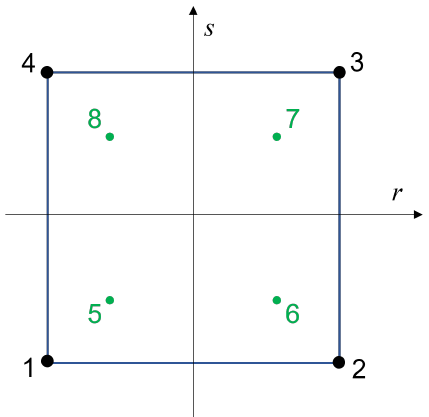
Figure 2. Four-noded quadrilateral element in the local curvilinear coordinate system with 2 × 2 Gaussian quadrature